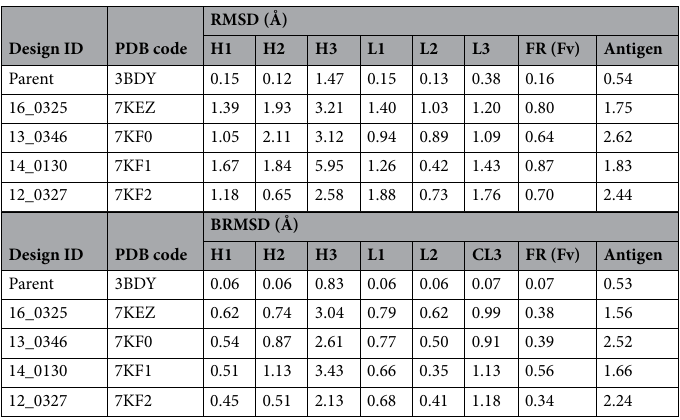
Table 3. Comparison between best scoring H3 loop conformation and crystal structure for 4 designs. PDB Code corresponds to the crystal structure used for the comparison to the predicted loop conformation of the design. Best-scoring H3 loop conformation are based on the Talaris total energy. The first copy in the crystal structure was used. IGMT definition was applied for delineation of CDR loops 46 . FR (Fv) is the framework the Fv region. Larger (B)RMSD values calculated for the for the antigen are due to superposition being directed towards one of two binding sites of the VEGF